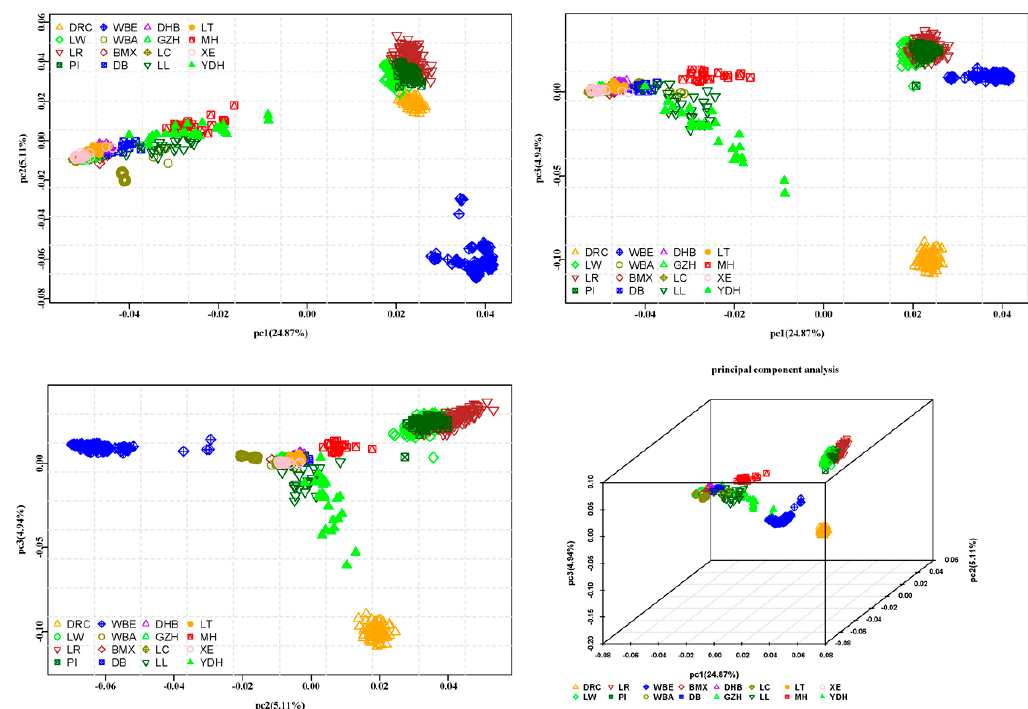
Figure 3. Principal component analysis results 1 . 1 DR = Duroc, LW = Large White, LR = Landrace, PI = Pietrain, WBE = European wild boar, WBA = Asian wild boar, BMX = Bamaxiang, DB = Debao, DHB = Dahuabai, GZH = Guizhonghua, LC = Luchuan, LL = Longlin, LT = Lantang, MH = Meihua, XE = Guangdongxiaohua, YDH = Yuedonghei.